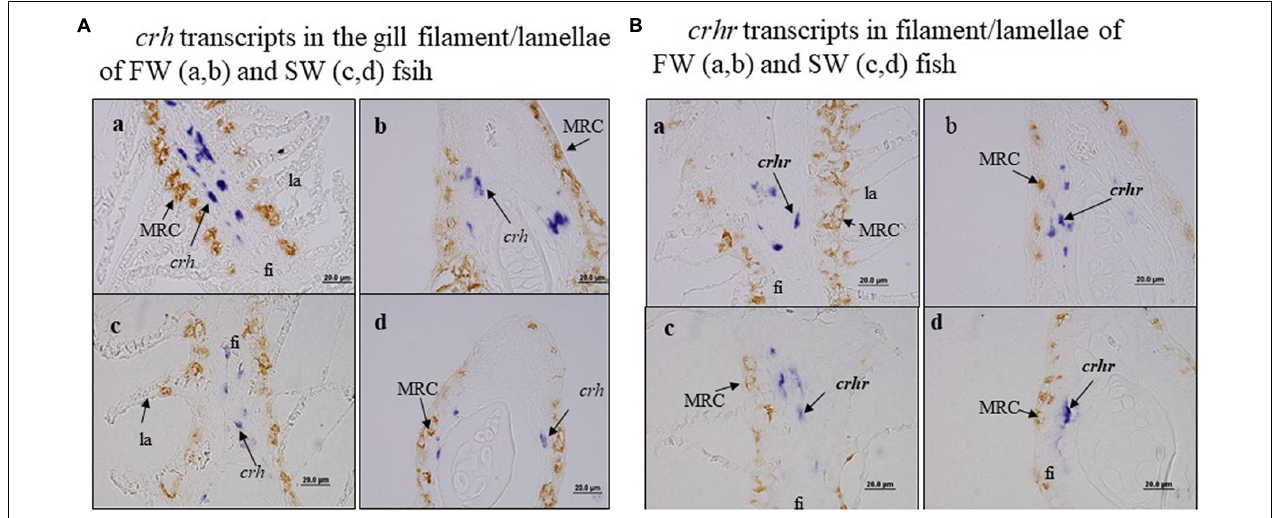
FIGURE 4 | There was no co-localization of crh transcript cells vs. a-Nka cells and crhr transcript cells vs. a-nka cells in the gill filament of FW and SW fish. Fi, filament; la, lamellae. (A) crh transcripts in the gill filament/lamellae of FW (a,b) and SW (c,d) fish. (B) crhr transcripts in filament/lamellae of FW (a,b) and SW (c,d)